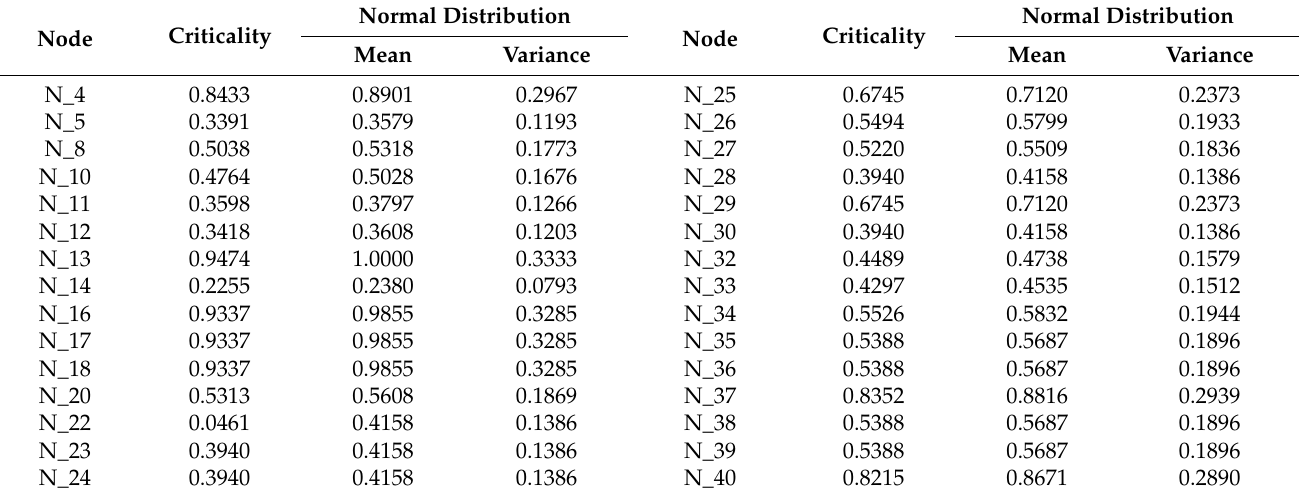
Table 6. The criticality and probability distribution for root nodes.